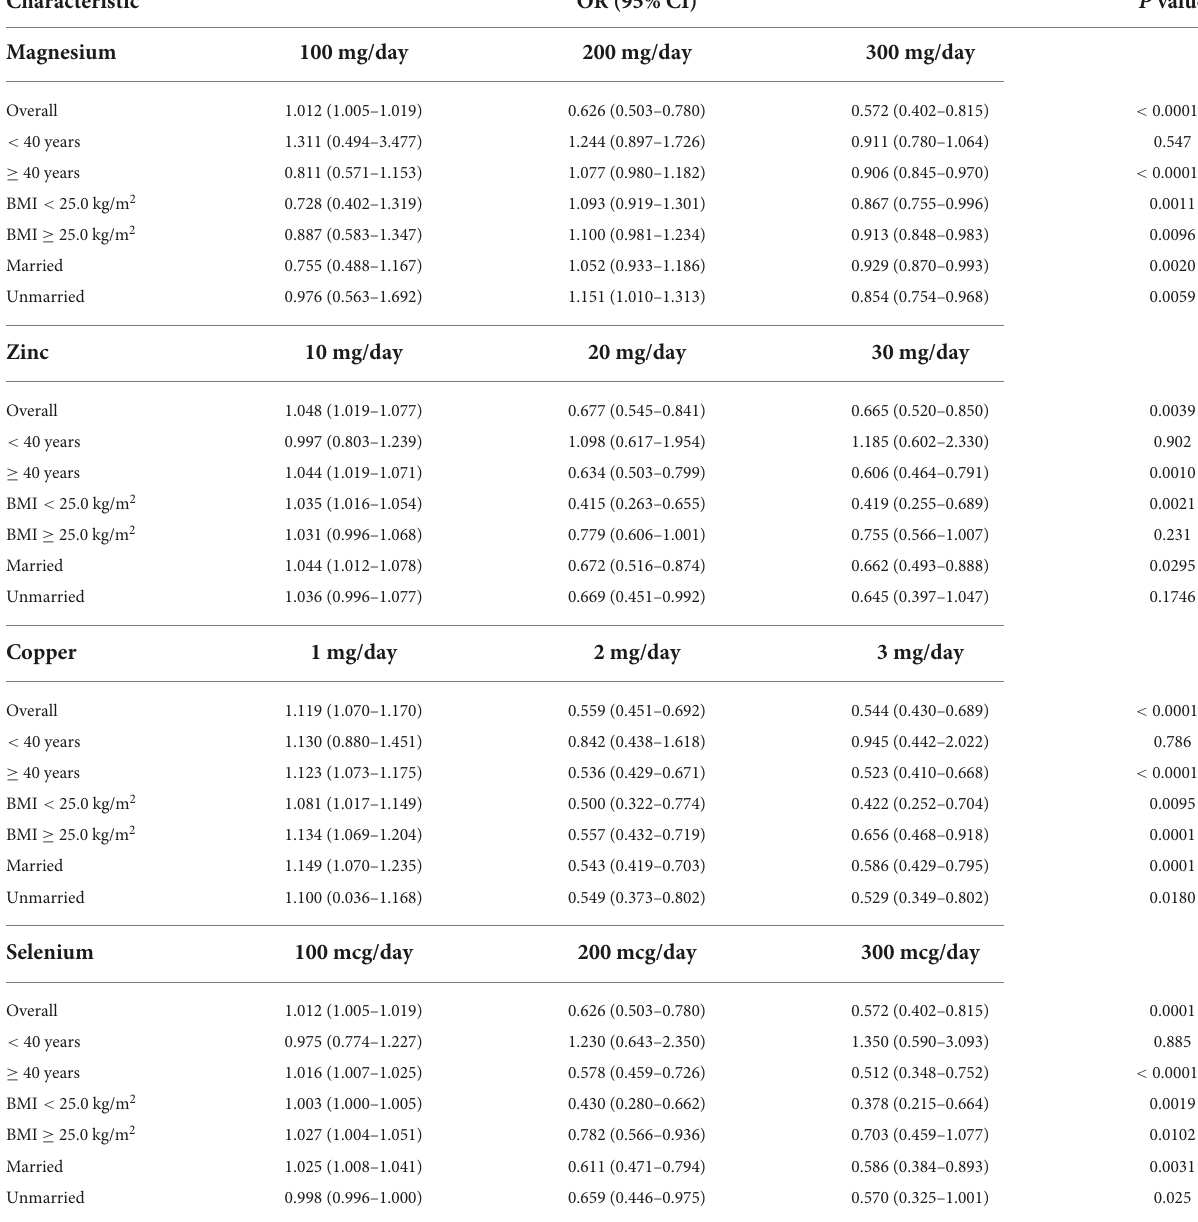
TABLE 5 Subgroup analysis of dietary metal intake and erectile dysfunction in national health and nutrition examination survey (NHANES) 2001–2004 after propensity score matching (PSM).